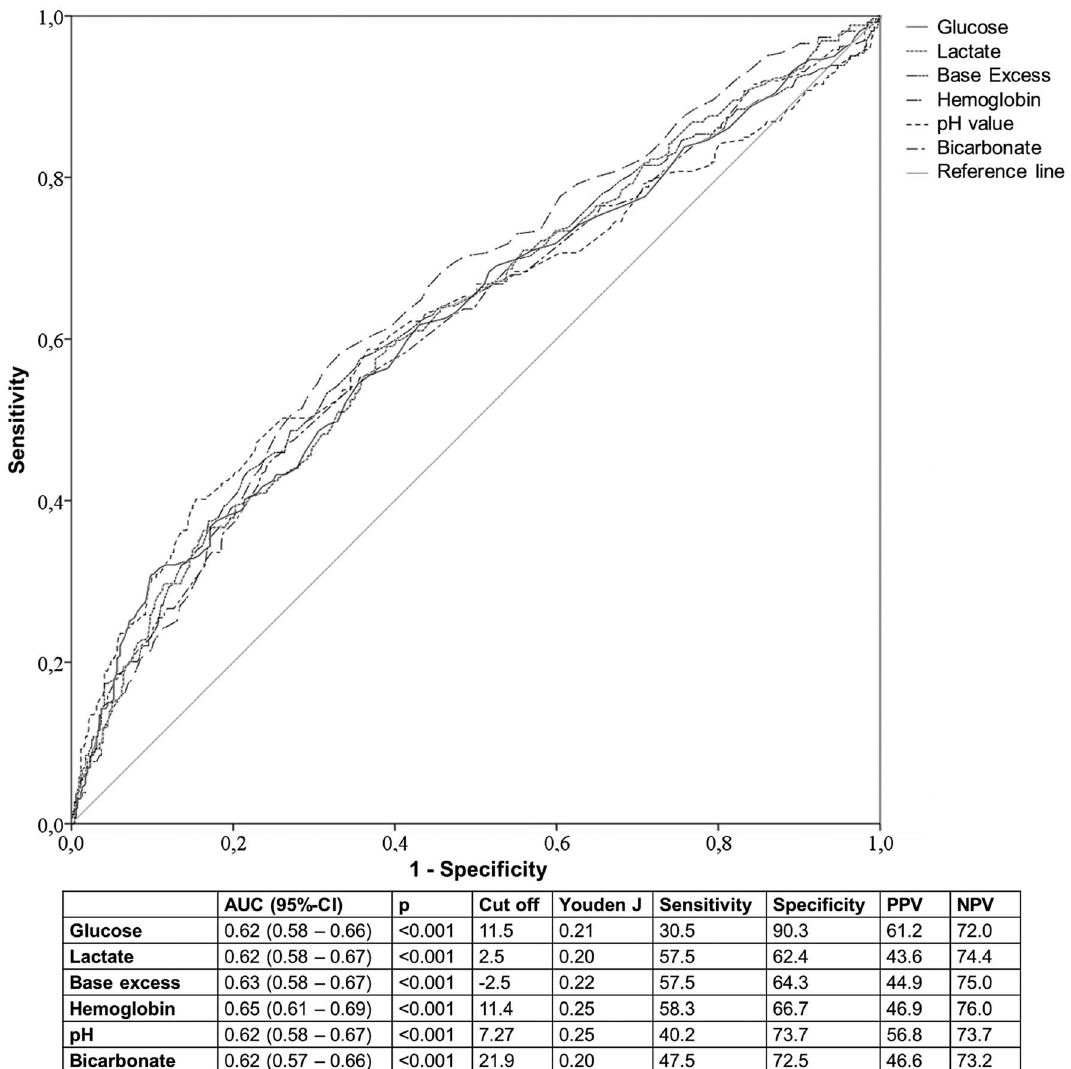
Figure 2. Receiver operating characteristic (ROC) curve and area under the curve (AUC) with 95% con fi dence interval (95% CI) of clinical and laboratory indicators of shock at admission in multiply injured patients; cut off value by means of Youden index ( J ) with sensitivity, speci fi city, positive predictive value (PPV), and negative predictive value (NPV); SBP = systolic blood